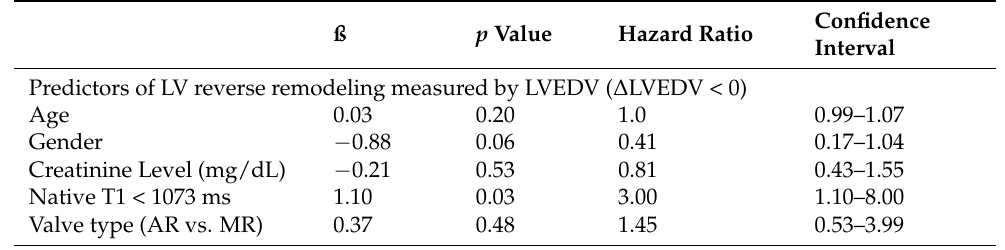
Table 2. Predictors of LV reverse